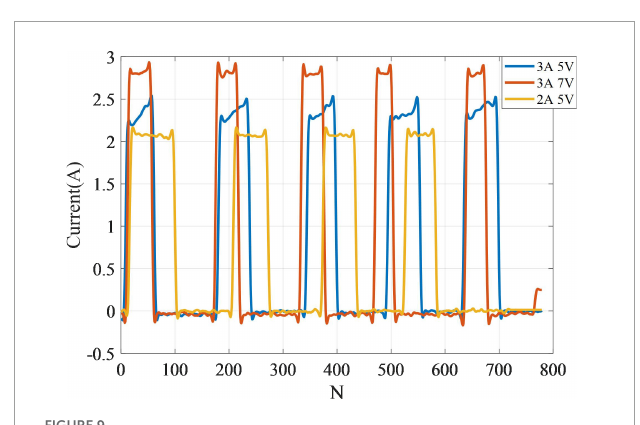
FIGURE9 The current change of SSCS during